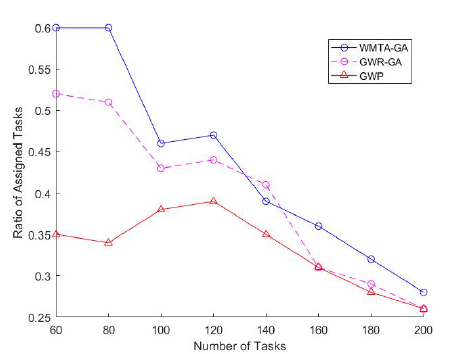
Figure 2. Impact of Varying Number of Tasks on Worker Welfare.